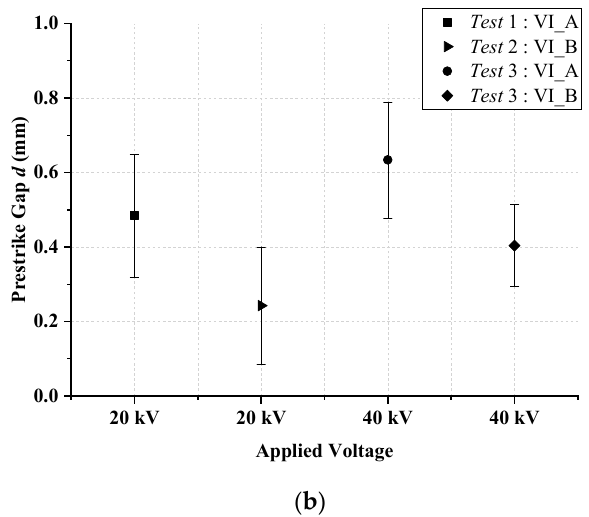
Figure 10. The negative effects of double-break vacuum circuit breakers (VCBs) on the prestrike gaps of vacuum interrupters. ( a ) The single-break VCB under 10 kV compared with the double-break under 20kV. ( b ) The single-break VCB under 20 kV compared with the double-break under 40kV.